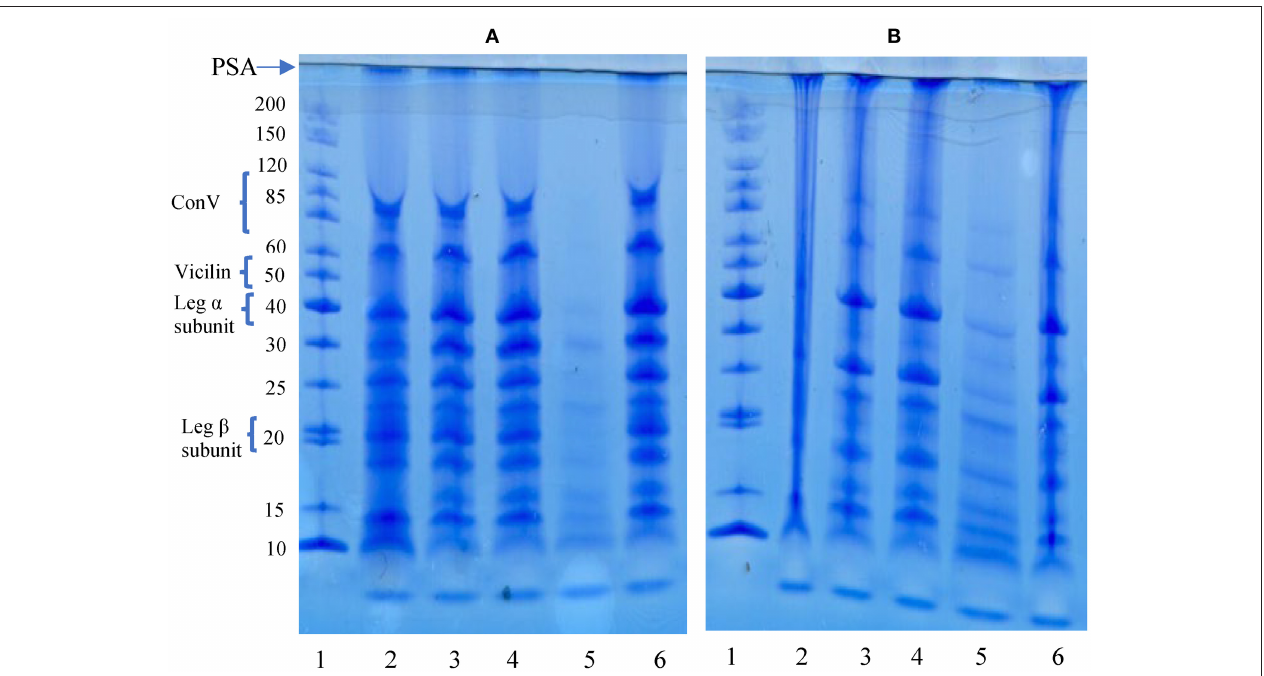
FIGURE 2 | SDS-PAGE under reducing (A) and non-reducing (B) conditions. PSA, point of sample application. Lanes: 1, standard proteins; 2, pea protein concentrate (PPC); 3, FT3; 4, FT5; 5, FT7; 6, FT9. PPC was heated at 100 ◦ C and varying pH, centrifuged and the supernatant passed consecutively through 30 and 50 kDa membranes. The final retentate from the 50 kDa membrane was collected as FT3, FT5, FT7, and FT9 for heat treatments at pH 3.0, 5.0, 7.0, and 9.0, respectively.